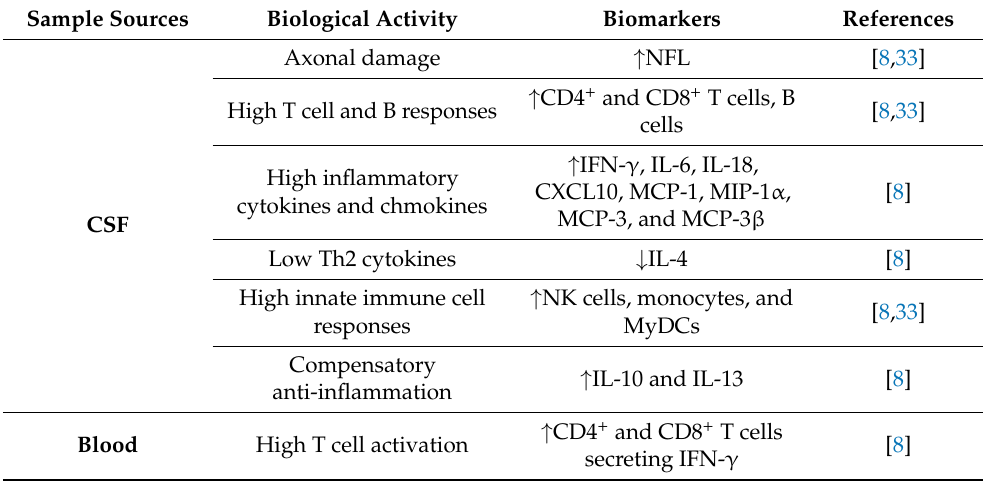
Table 3. Biomarkers at the time of cryptococcal PIIRS